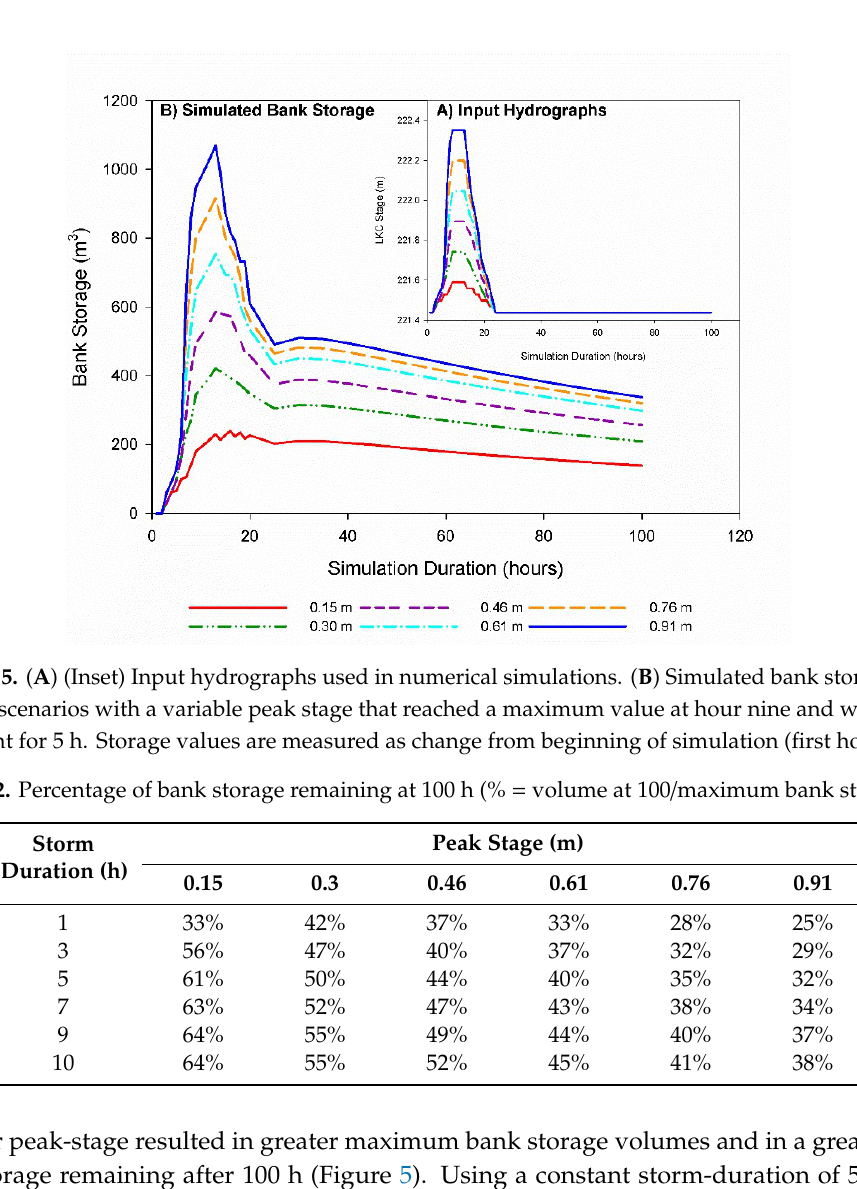
8 of 16 Table 2. Percentage of bank storage remaining at 100 h (% = volume at 100/maximum bank storage). Storm Duration (h)